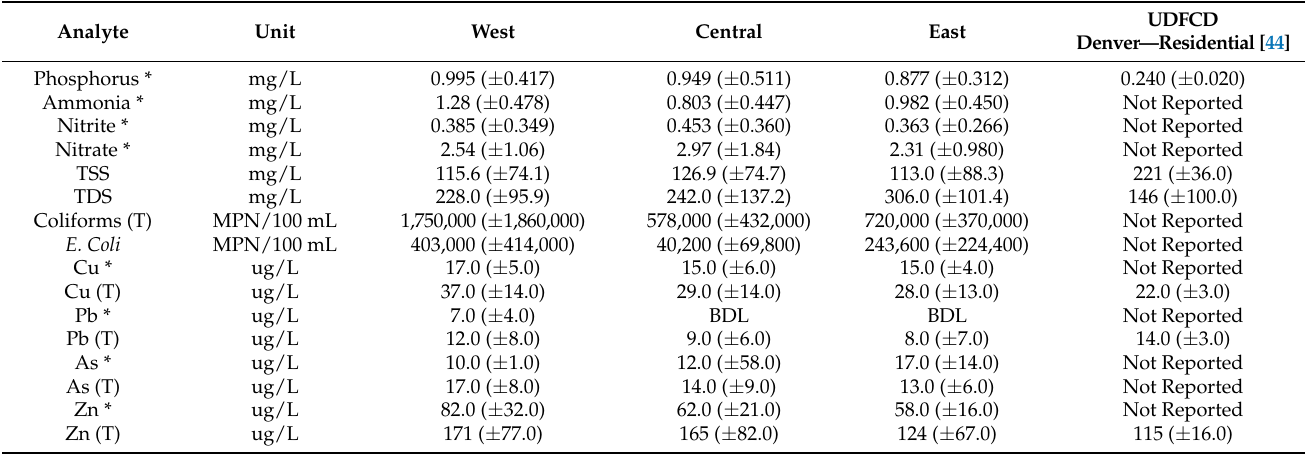
Table 7. Wet weather water-quality descriptive statistics (mean ± 95% CI).